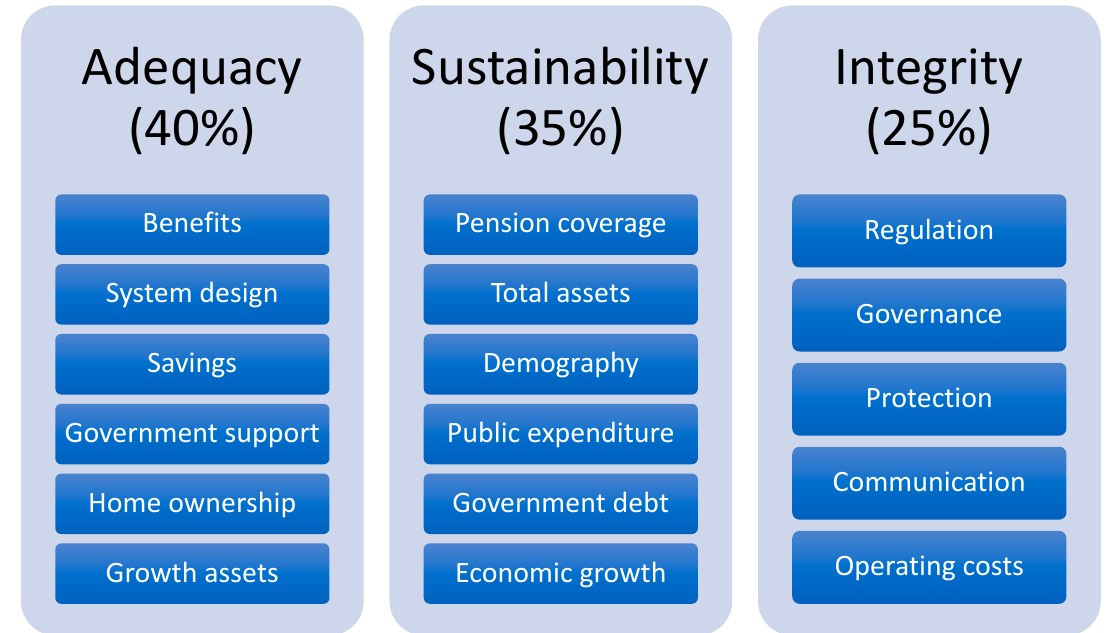
Figure 1. The sub-element of adequacy, sustainability, and integrity. Source: Mercer CFA Institute (2021).